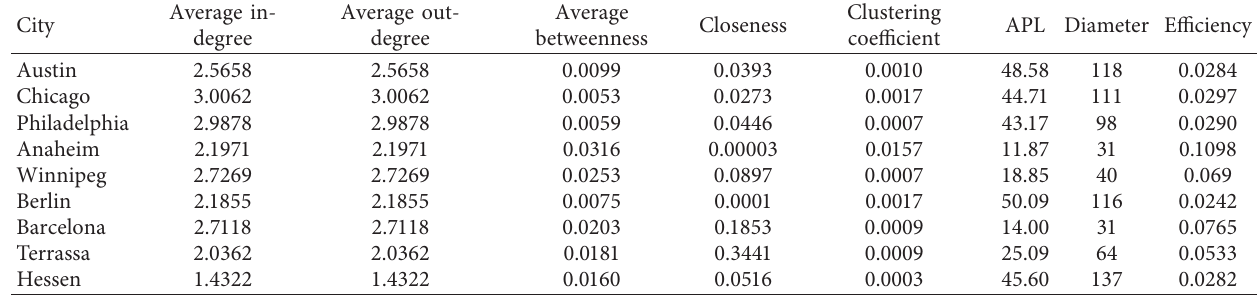
Table 3: Indices of nine urban road networks.